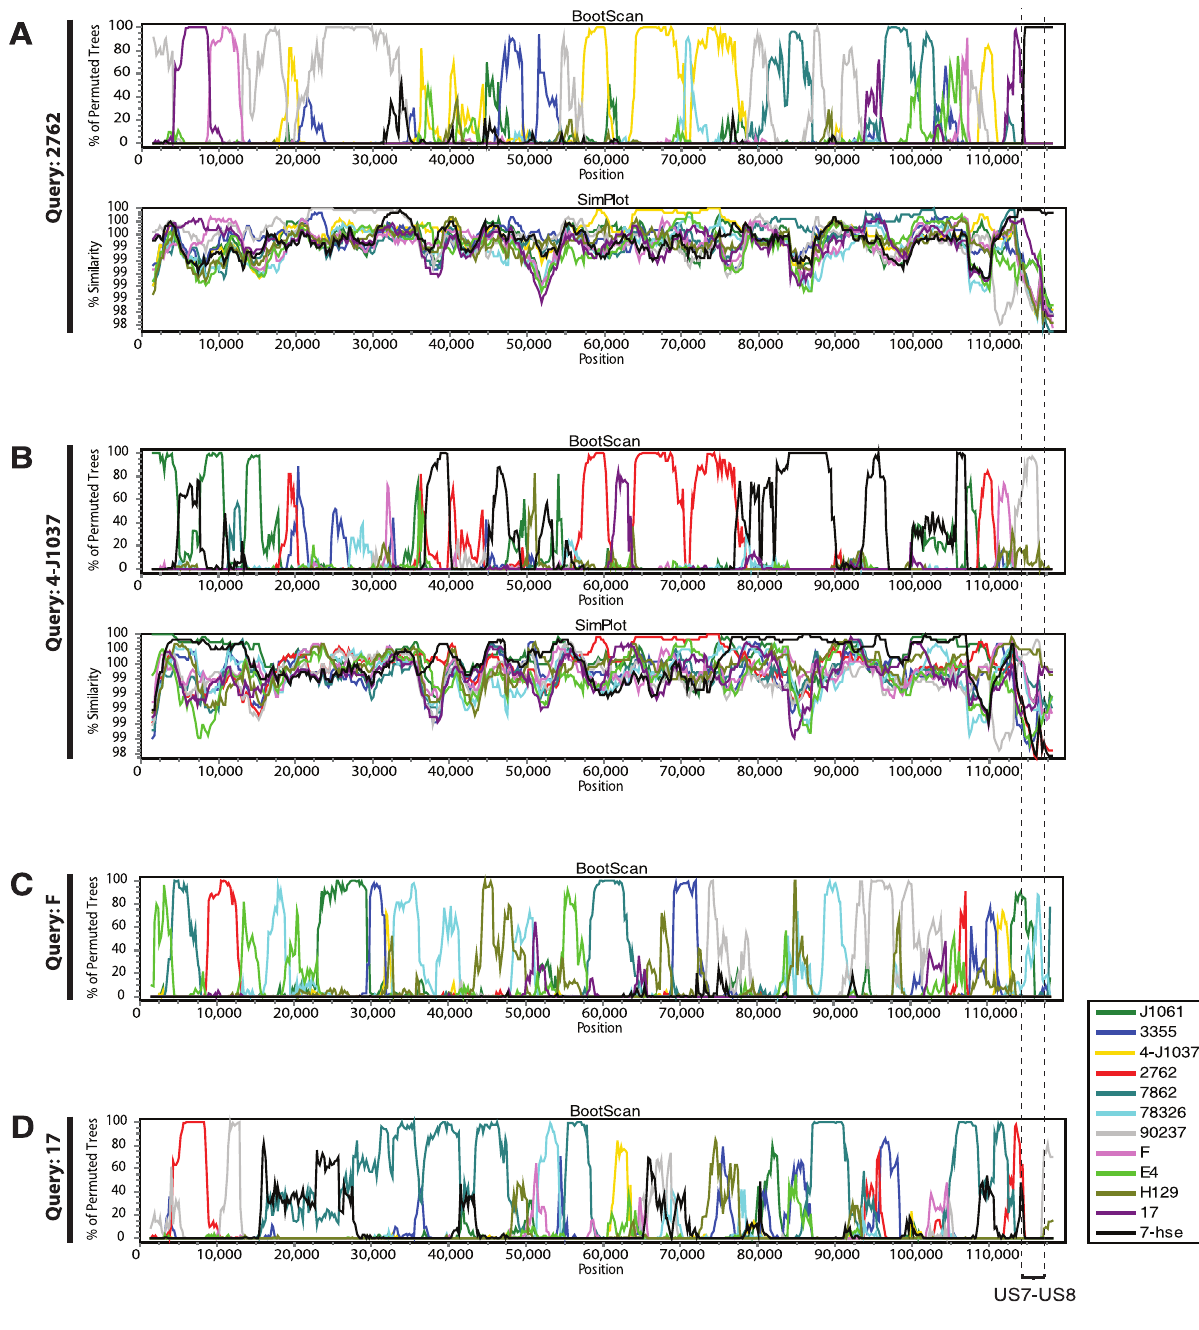
Figure 2. HSV-1 recombination analysis. Recombination analysis using Bootscan and SimPlot. A and B illustrate the bootscan and SimPlot analysis of query sequences 2762 and 4-J1037, respectively, which were classified as non-recombinants based on the US7–US8 regions. Bootscan plots demonstrate highly fragmented genomes as a result of recombination. Similarity plots demonstrate the sequence similarity between the query sequence and the other sequences. C and D depicts the bootscan analysis of the reference strains F and 17. Nucleotide positions refer to the sequence alignment excluding gaps and repeat regions.